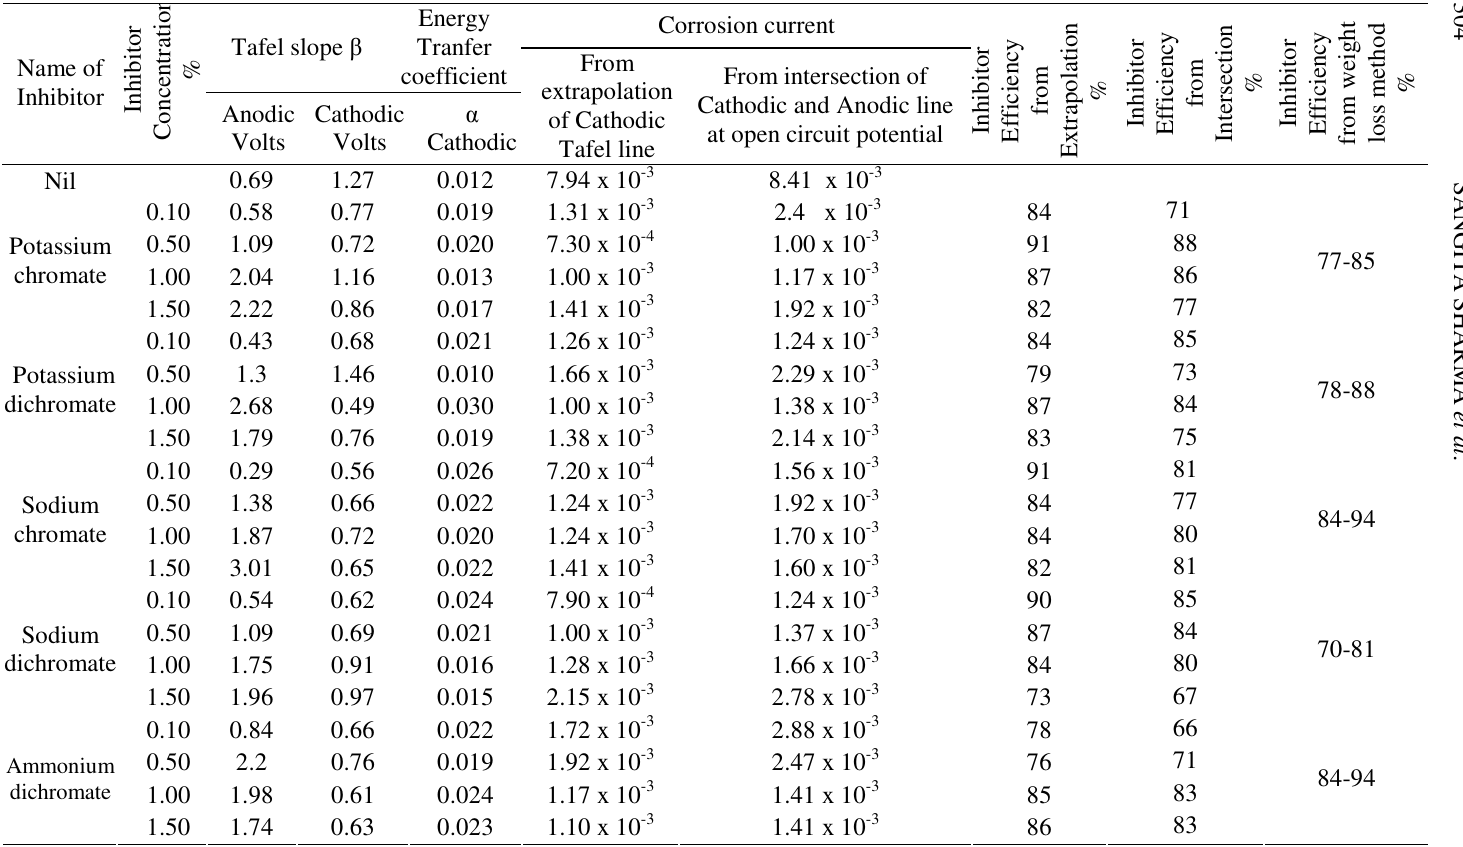
Table 1 . Tafel parameters and efficiency of Inhibitors of Tin Coated Steel in 0.5M Monochloroacetic acid at Temperature : 35±0.1 0